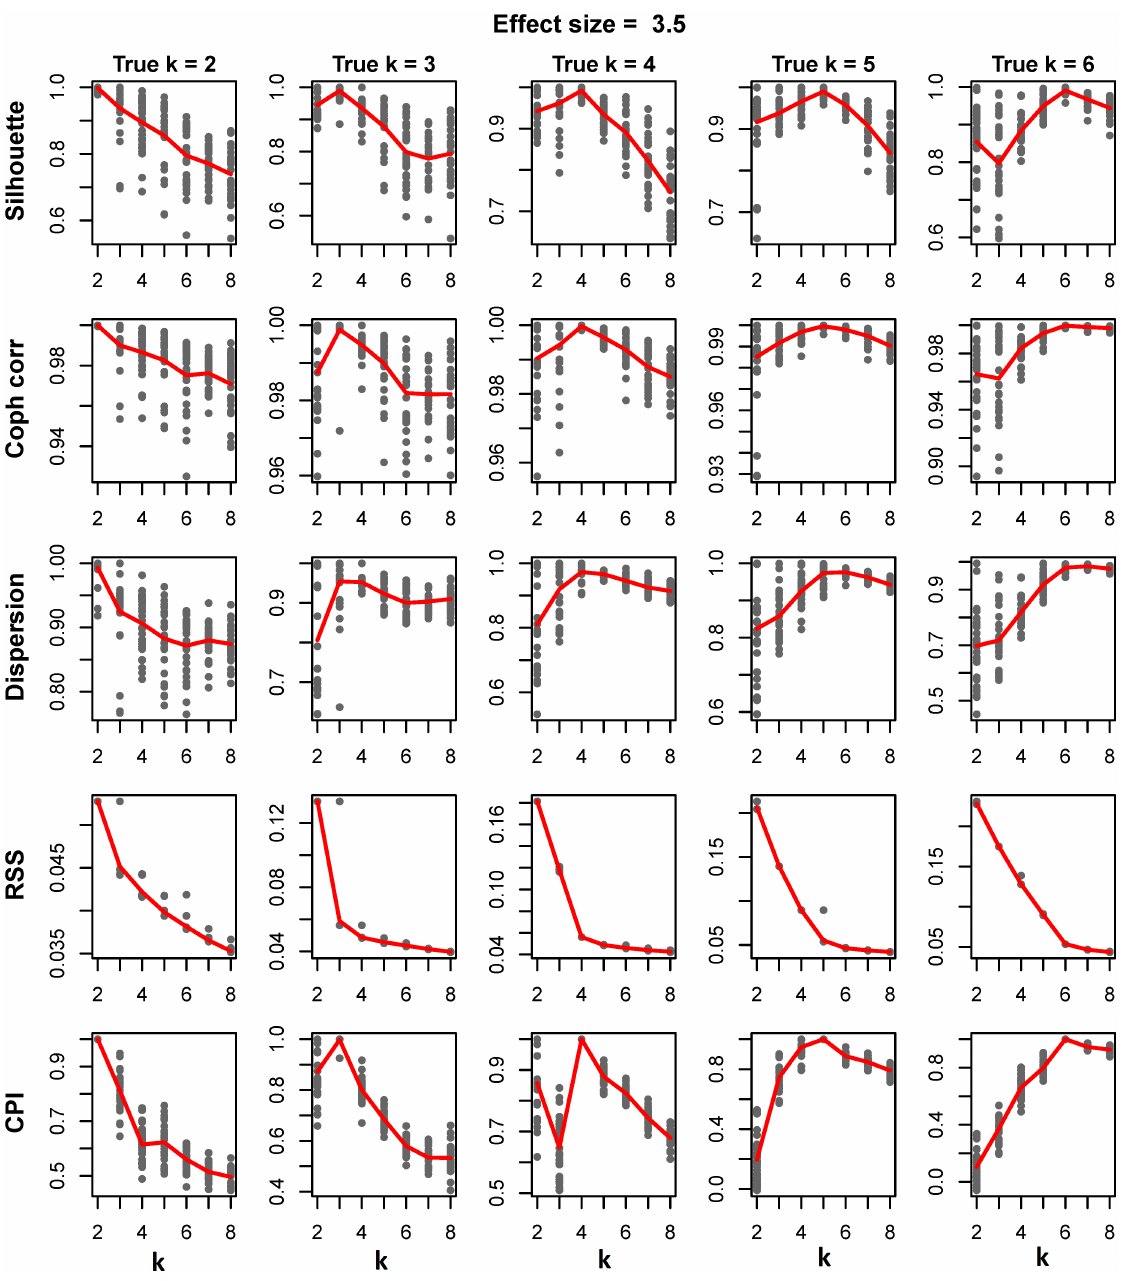
Fig 1. Finding optimum number of clusters. The plots represent the comparisonof five different methods of finding optimum numberof clusters on the dataset generatedusing moderate effect size of 3.5. First row represents silhouettewidth over k = 2:8 for each of five different scenariosof true clusters 2, 3, 4, 5 and 6 over 30 runs of simulation. The averagevalue of the silhouette widths over 30 runs are overlaidon the plots as a line. Cophenetic correlation,Dispersion,ResidualSums of Squares and Cluster Prediction Index are shown on second, third, fourth and fifth rows